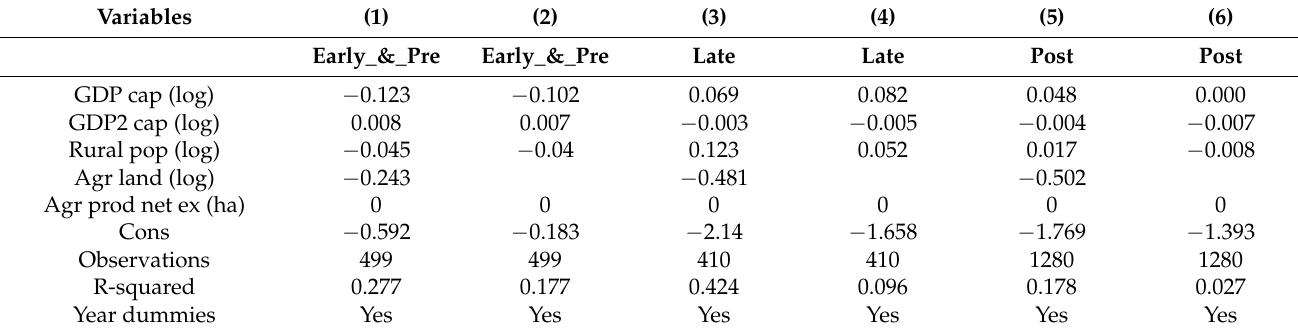
Table A4. Long run, forest transition clusters, net agricultural exports as additional control